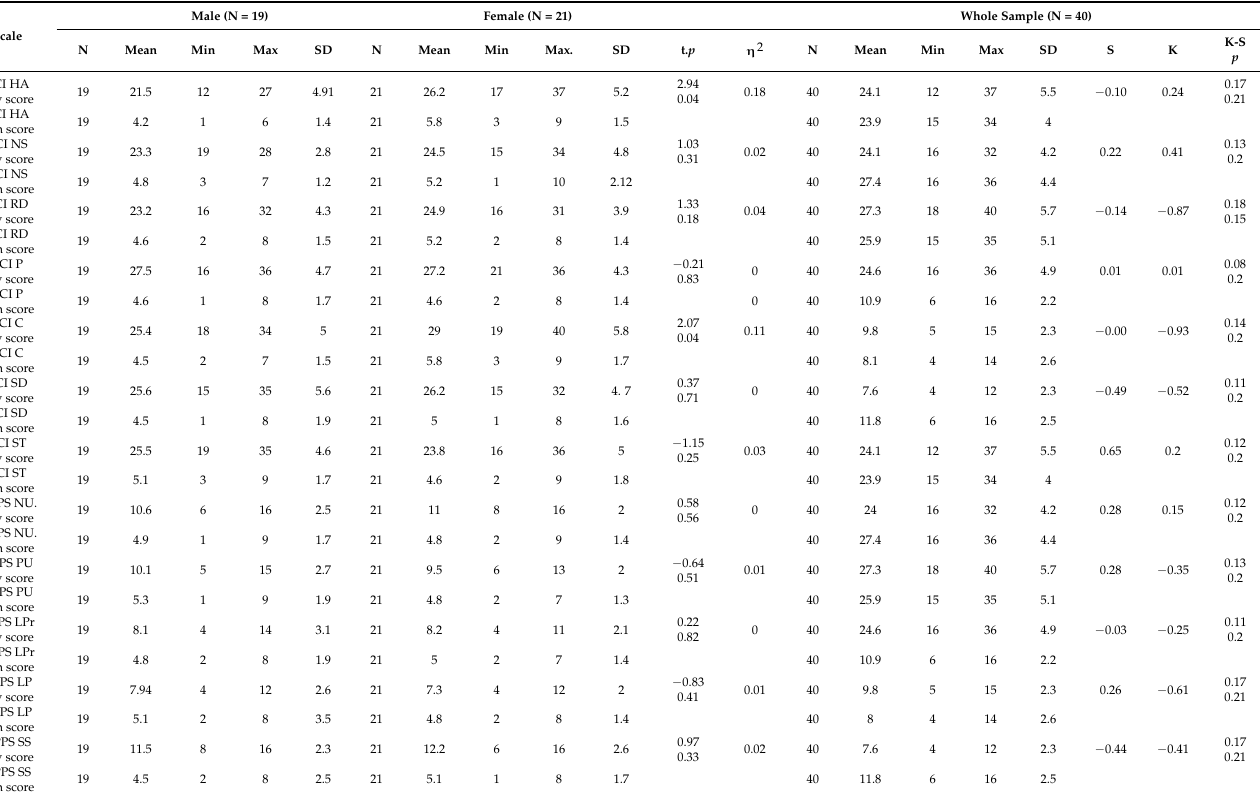
Table 1. Basic descriptive statistics of short track athletes in relation to TCI-R (56) scales and S-UPPS- P